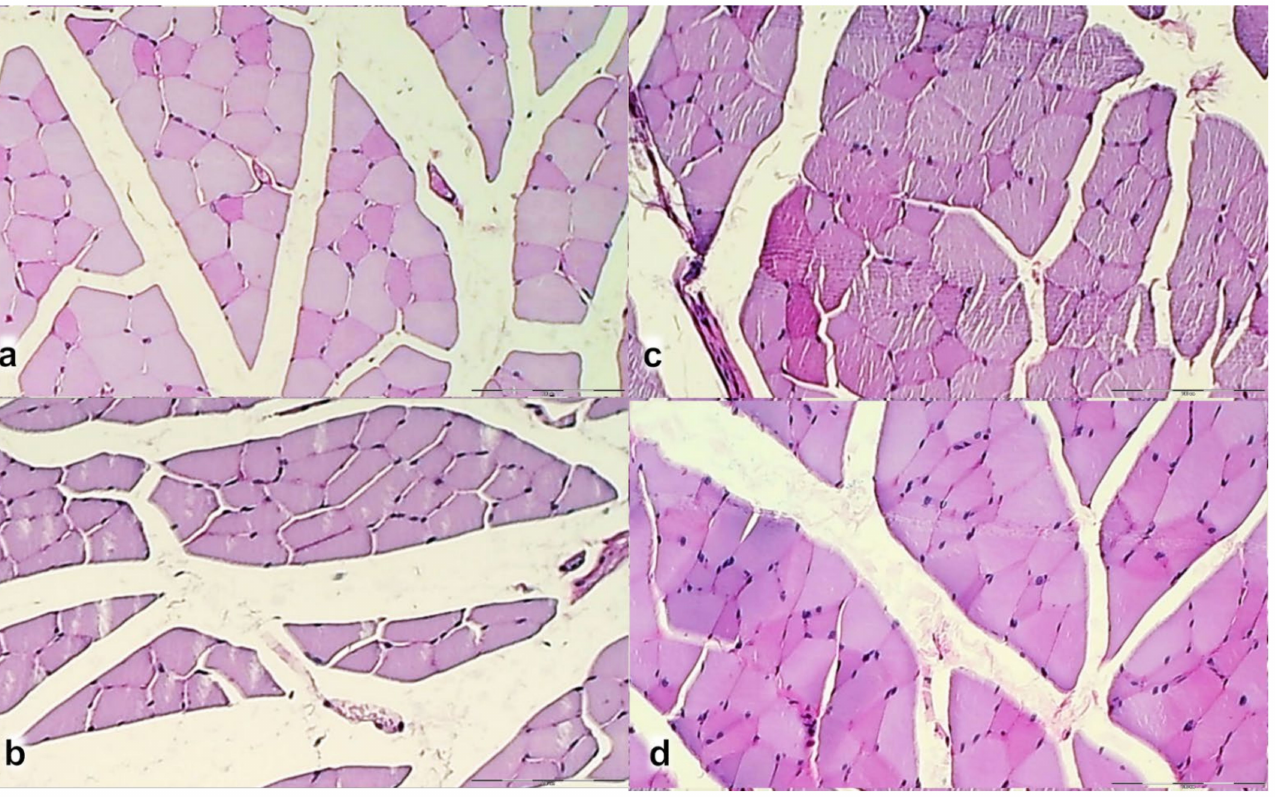
Figure 14. Periodic acid-Schiff stained cross-sections of the quadriceps muscle. ( a ). Control rats at day 28. The diversity of muscle fibers results in different PAS staining (PAS intensity staining + and +++). ( b ). Control rats at day 42. Loss of muscle fibers diversity results in monotonous PAS staining (PAS intensity staining +). BPC 157 rats at day 28 ( c ) and day 42 ( d ). The diversity of muscle fibers results in different PAS staining (PAS intensity staining + and +++). Magnification ×